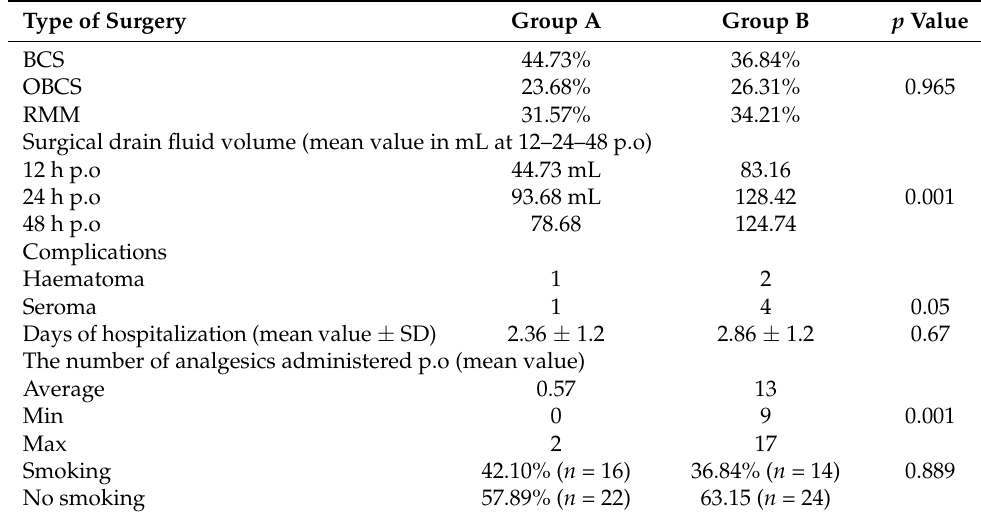
Figure 5. Time required for drainage suppression. A comparison between the two groups. With reference to the quantity of painkillers additionally administrated (Table 8), the average value was 0.57 vials per patient, with a maximum value of 2 vials for Group A vs. an average of 13.6 vials per patient and a maximum of 17 vials for Group B. Table 8. Paramedian and comparative distribution at the general batch level.